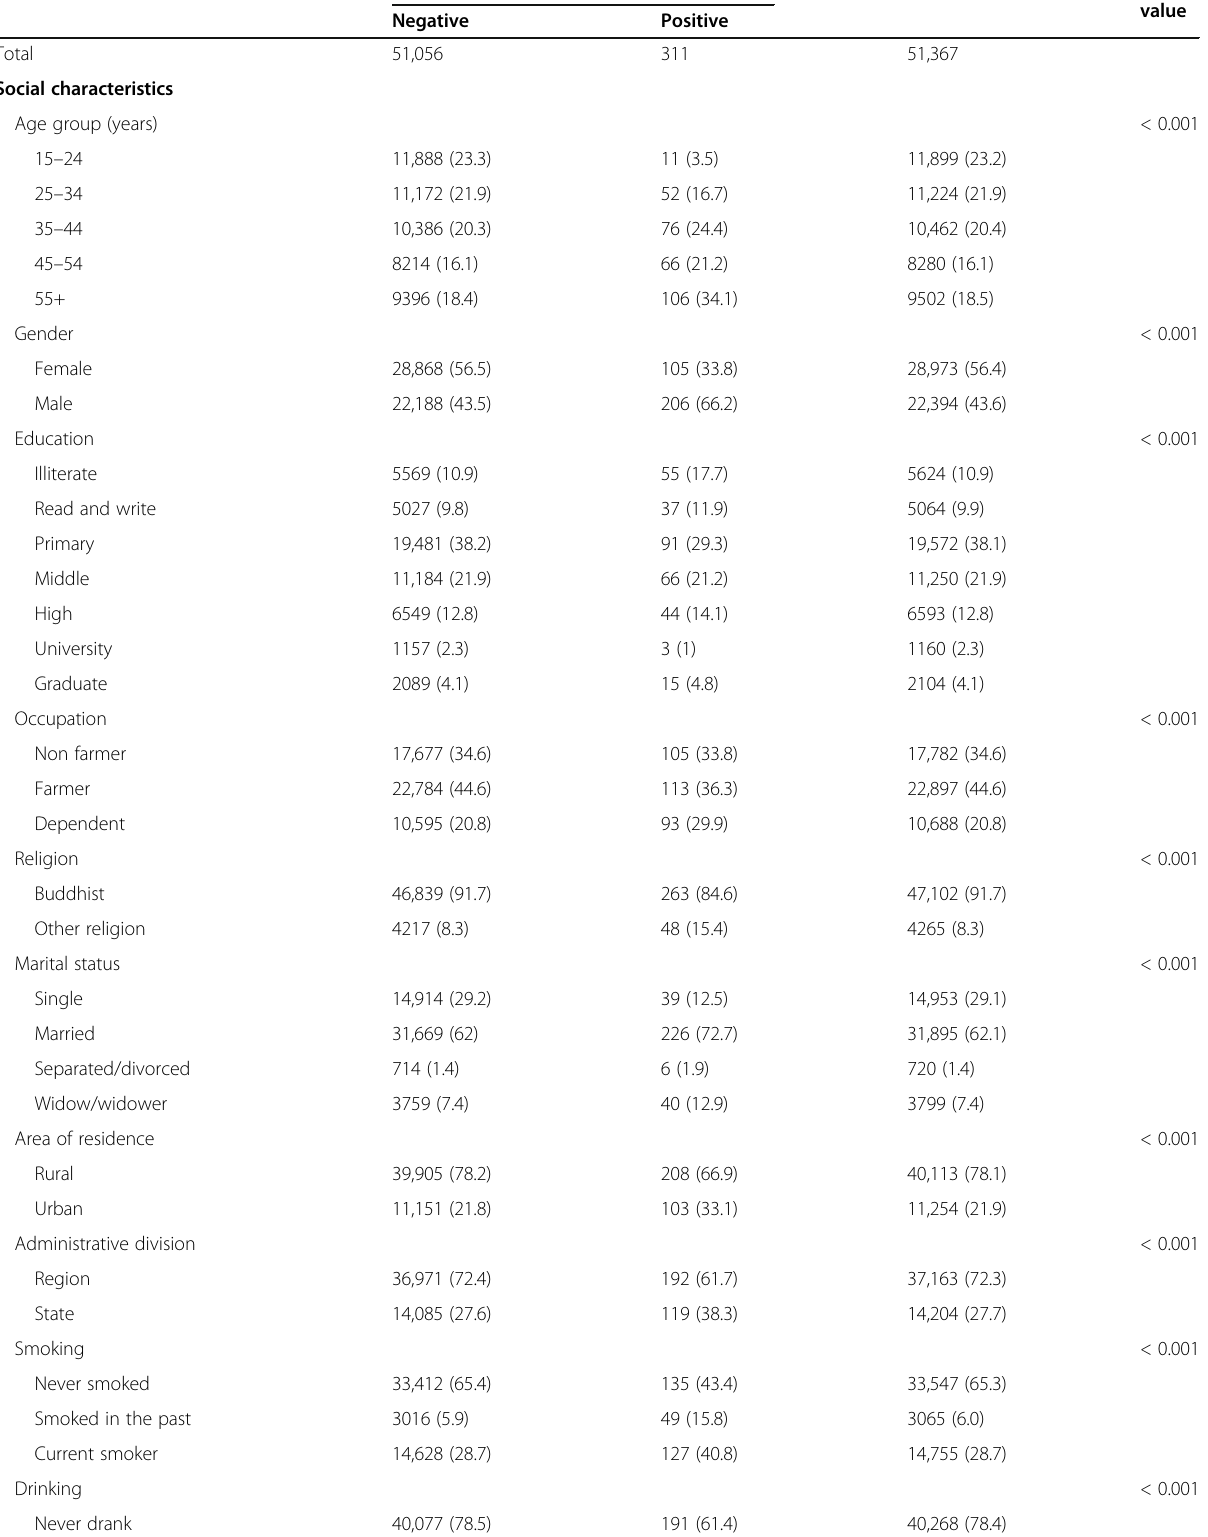
Table 3 Predictor variables associated with bacteriologically confirmed TB in univariate analysis Predictor